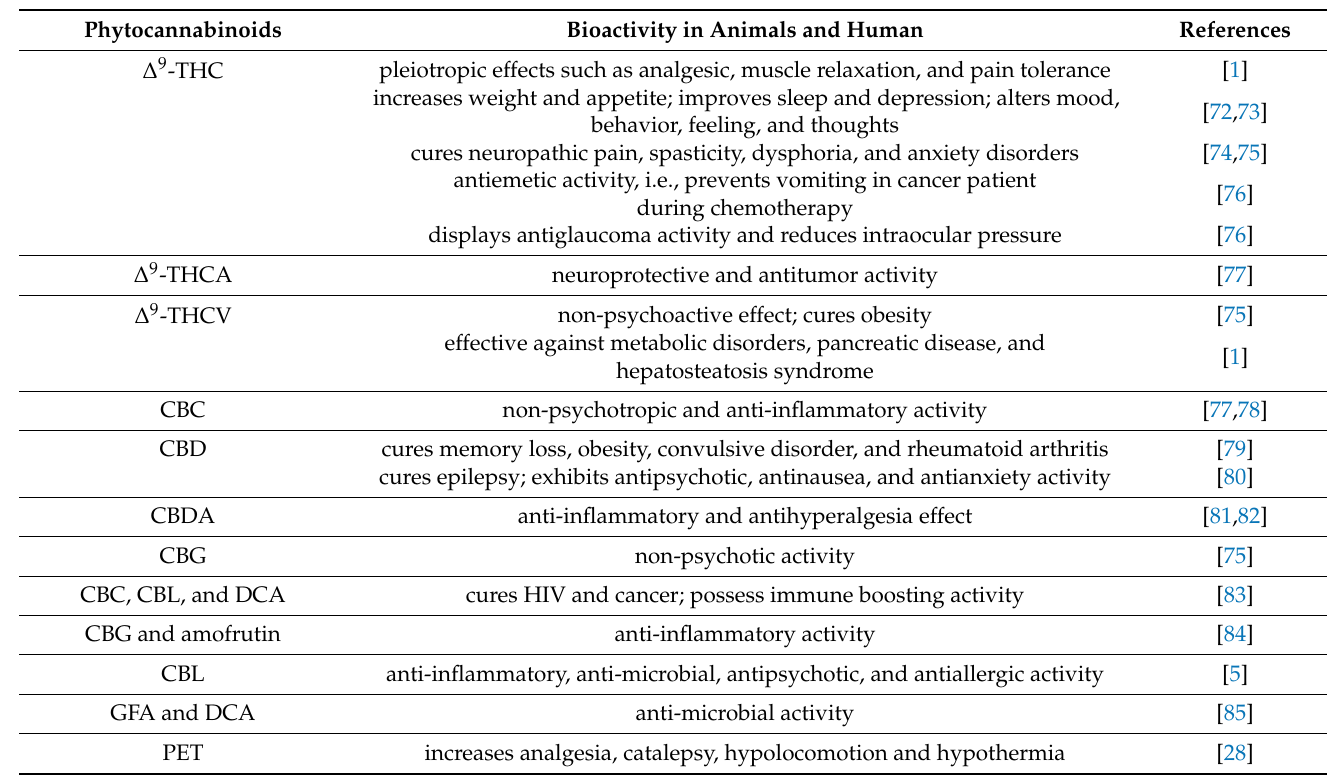
Table 1. Bioactivity and effect of different phytocannabinoid in animals and humans. Phytocannabinoids Bioactivity in Animals and